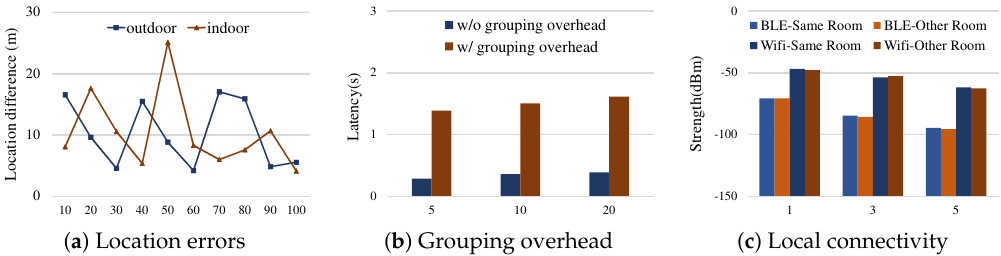
Challenges of conventional cloud-based and local connectivity approaches for the uncoordinated react problem: ( a ) the difference of location estimates (on y -axis) of the two smartphones of a same walking person over time, based on the 10 measurements at every 10 s during 100 s (on x -axis); ( b ) the latency of group information sharing (on y -axis) with respect to the group size (on x -axis), where the grouping overhead denotes the case where no provisioned group connections are managed, thus requiring the time for establishing the group connection upon a request; and ( c ) the measured strength averages (on y -axis) of BLE and WiFi signals with respect to the distances between the signal source and the receiver (on x -axis) where the measurement was performed 100 times for each distance and connectivity. All tests were performed with Samsung Galaxy S8 and S6